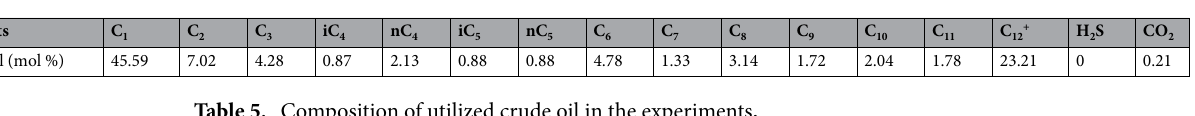
Table 5. Composition of utilized crude oil in the experiments